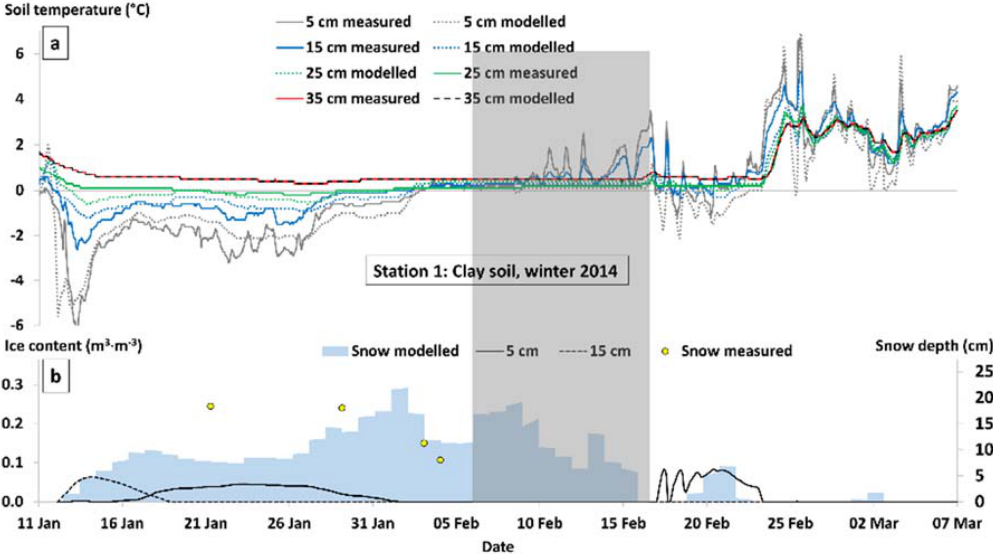
Figure 7. Diagram of ( a ) modelled and measured soil temperature at four depths (5, 10 and 20 cm) in the clay soil (at Station 1) during winter 2014; diagram of ( b ) measured and modelled snow depths at Station 1 and modelled ice content at four depths in the clay soil (was zero at 25 and 35 cm). The duration of the rain event of interest is marked with a grey band.